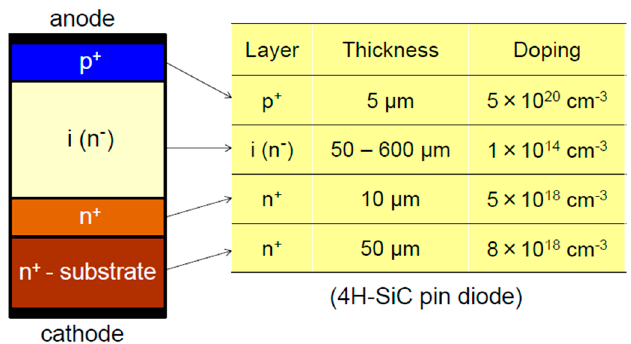
Figure 1. Schematic structure of a SiC pin diode simulated in this study.